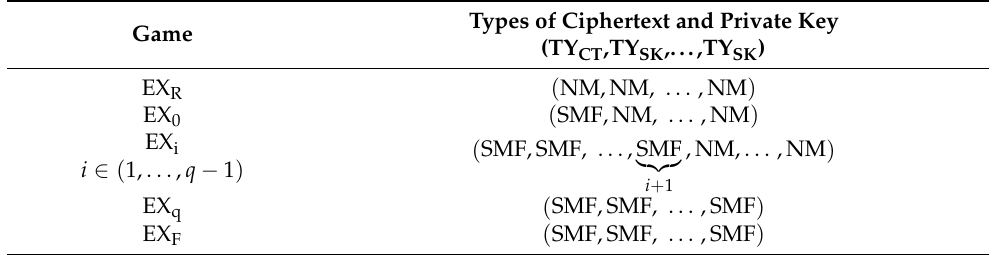
Table 2. The forms of the ciphertext and the private key for every game (CLR-SS-AIBBE). Types of Ciphertext and Private Key Game